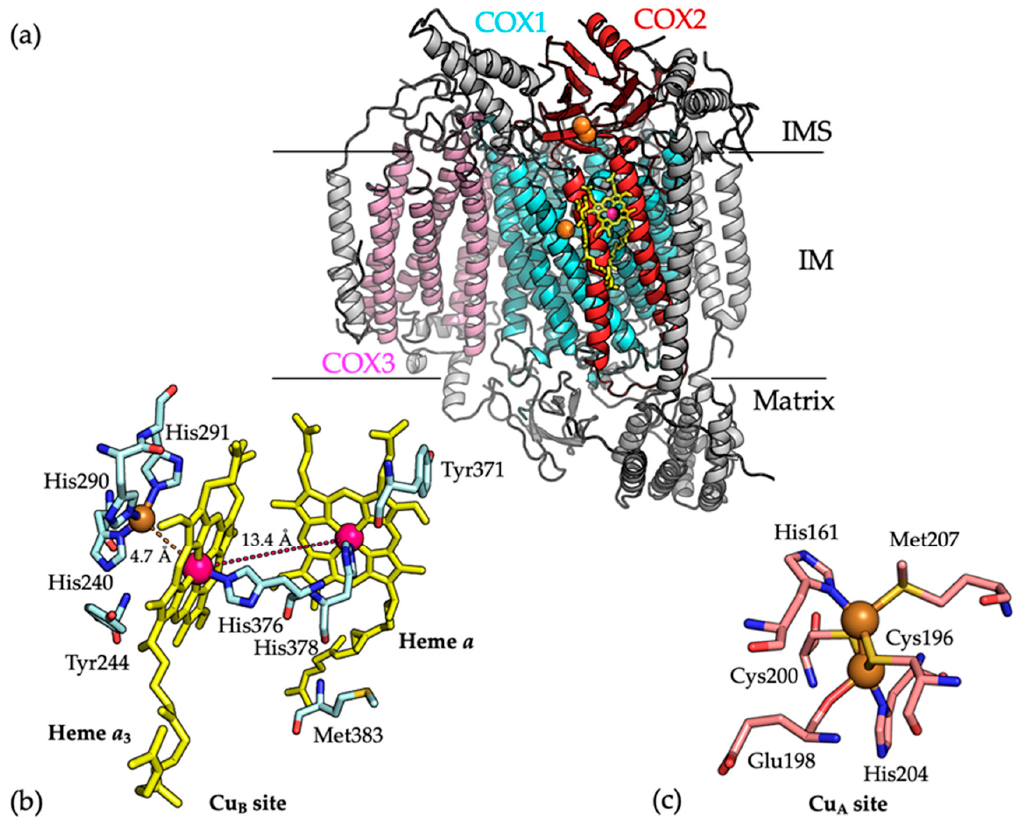
Figure 1. ( a ) The overall structure of the monomeric bovine COX (PDB 1OCC) [5]. All secondary structures are shown as cartoons. COX1, COX2, and COX3 subunits are colored in cyan, red and pink, respectively. Copper ions are shown as orange spheres and heme a and heme a 3 are shown as yellow sticks. Other remaining subunits are colored in gray for clarity. ( b ) The mononuclear Cu B site, which is located in close proximity to the heme a 3 (4.7 Å), binds one copper ion via coordination with residues His240, His290, and His291. Residues located (labeled) at the Cu B site are shown as cyan sticks. The copper (Cu) and iron (Fe) atoms are shown as orange and pink spheres, respectively. Heme a and heme a 3 are shown as yellow sticks, where the distance between their Fe atoms is 13.4 Å which is shown as a dashed line. Carbon, oxygen, nitrogen and sulfur atoms are colored cyan, red, blue and yellow, respectively. ( c ) Residues located at the Cu A site (labeled) are shown as sticks. Copper ions are shown as orange spheres. A cluster of two copper atoms, bridged by Cys196 and Cys200 residues constitutes the Cu A site. One copper ion coordinated by the imidazole group of His161 and the thioether group of Met207 while the other copper ion is coordinated by His204 and the carbonyl group of Glu198. Carbon, oxygen, nitrogen and sulfur atoms are colored cyan, red, blue and yellow, respectively.